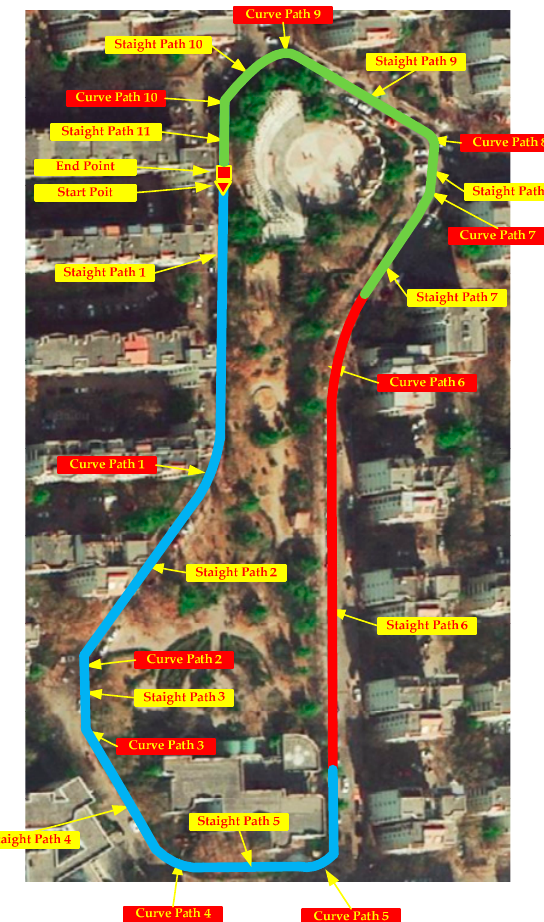
Figure 7. The complex irregular path is located in Shimen Community, Shijiazhuang City, Hebei Province, with 11 straight path segments and 10 curved path segments. Table 2. The total dimensions of the circuit and of each segment. SP is the abbreviation of straight path. CP is the abbreviation of curved path.